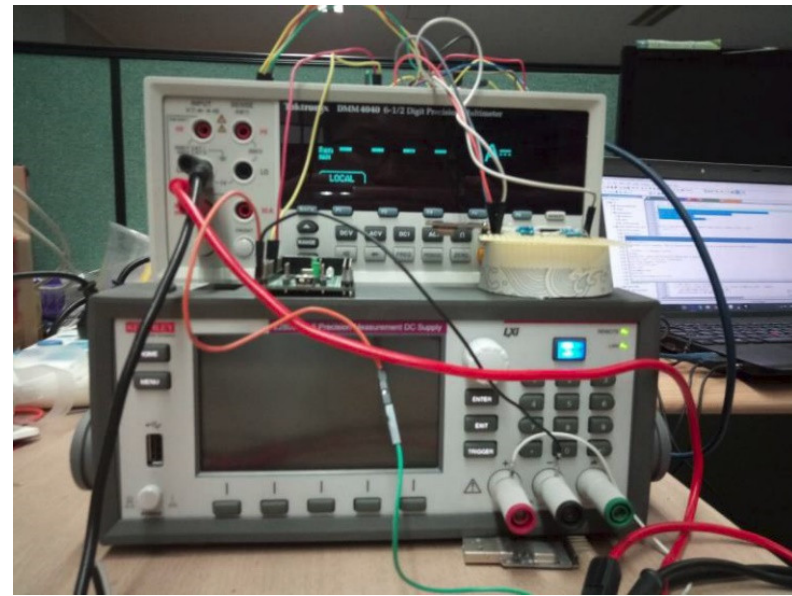
Figure 3. The measuring platform.